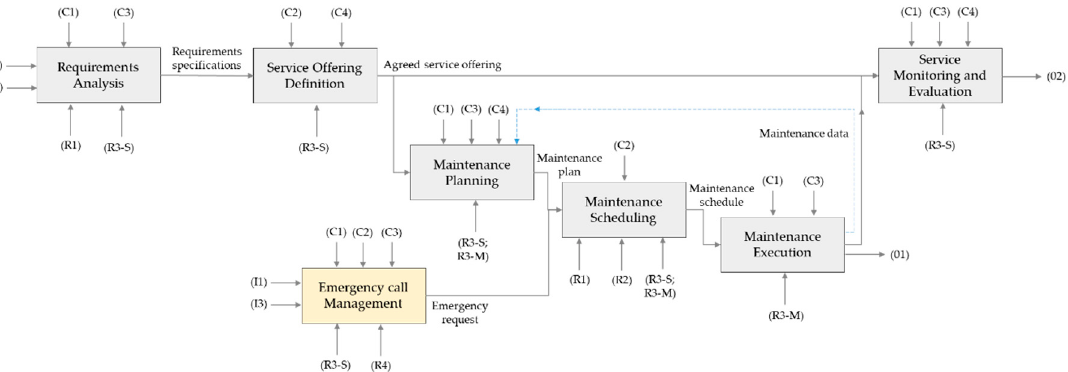
Figure 2. IDEF0 second ‐ level diagram for PBMS.